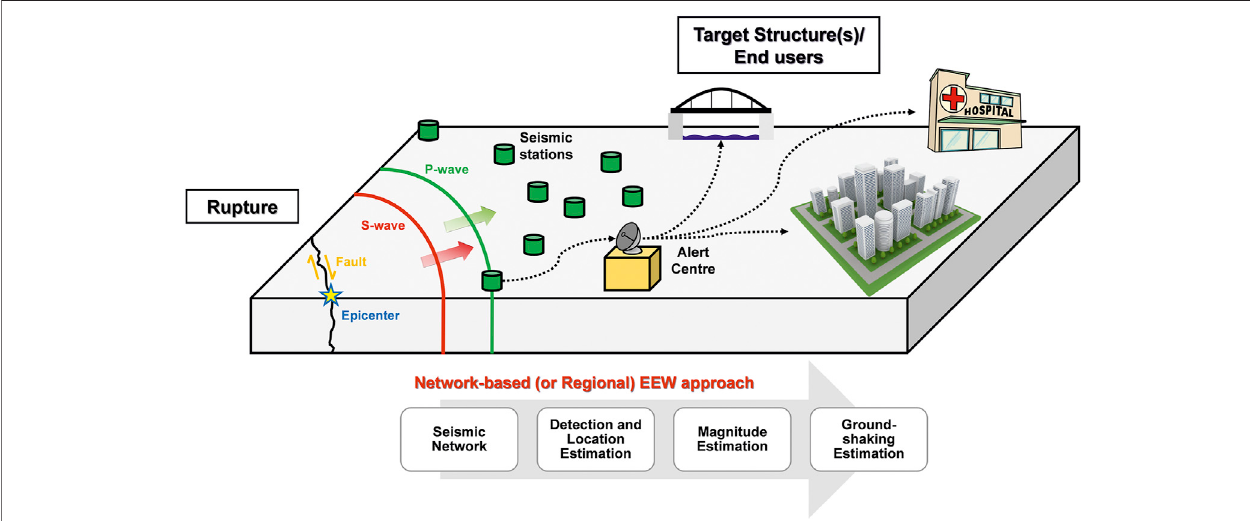
FIGURE1| TheprinciplesofastandardregionalEEWsystemandconceptual outlineofthecorrespondingEEWprocess.InformationfromanEEWsystemsensor network is input to an EEW algorithm to detect events and compute estimates of earthquake location, magnitude, and ground-motion amplitude. An alert may then be issued to warn end users of impending